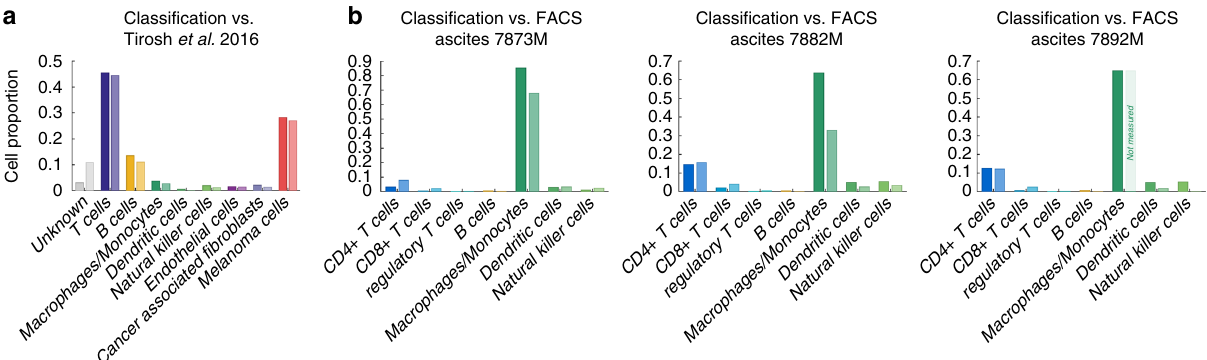
Fig. 2 Benchmarking the cell type classi fi cation to literature and experimental FACS analysis. a The result of our cell type classi fi cation (left bars, dark colours) compared to the cell types provided across all melanoma samples in the data-set by Tirosh et al. 11,22 (right bars, light colours). b Cell type classi fi cation (left bars, dark colours) compared to FACS data (right bars, light colours) for three ovarian ascites patient samples. For sample 7892M, macrophages/monocytes quanti fi cation is missing for FACS